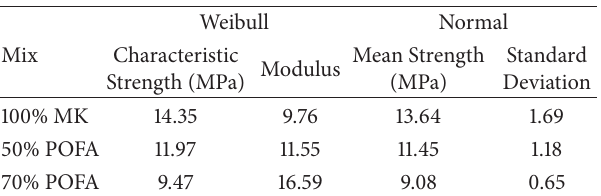
Table 4: Comparison of Weibull and Normal Distribution Parame- ters for Flexural Strength.